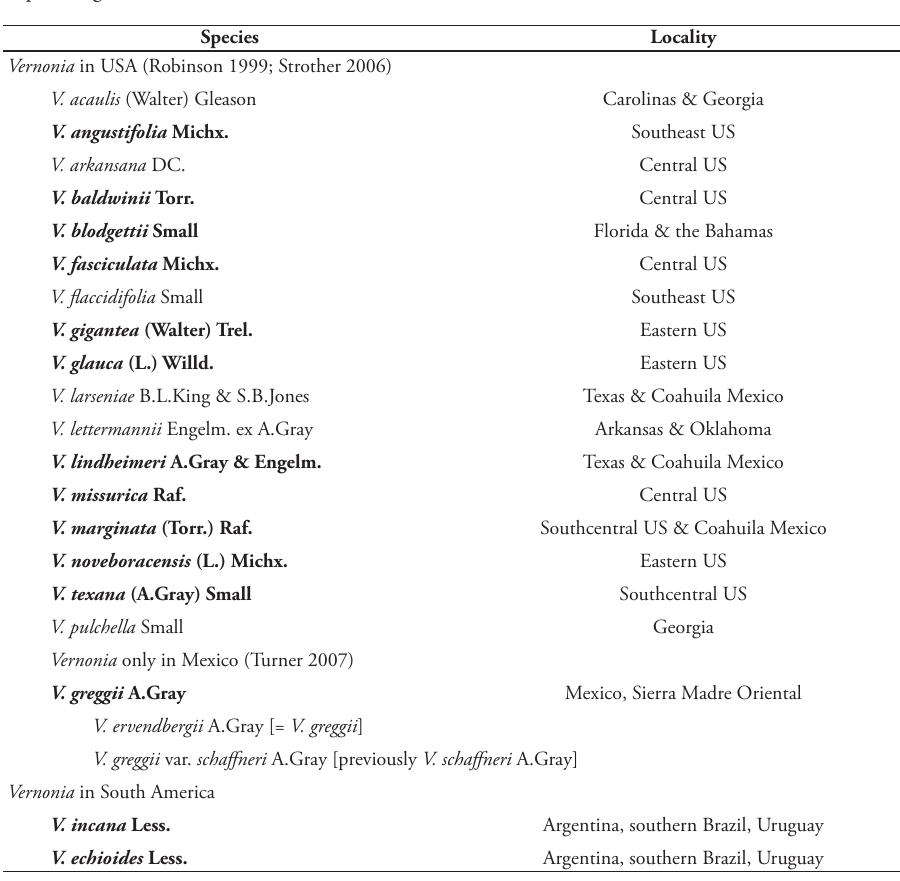
Table 1. Species of true Vernonia . Names in bold indicate that they have been sequenced. Two species, V. arkansana and V. lettermannii have recently been collected and will be added to future sequencing